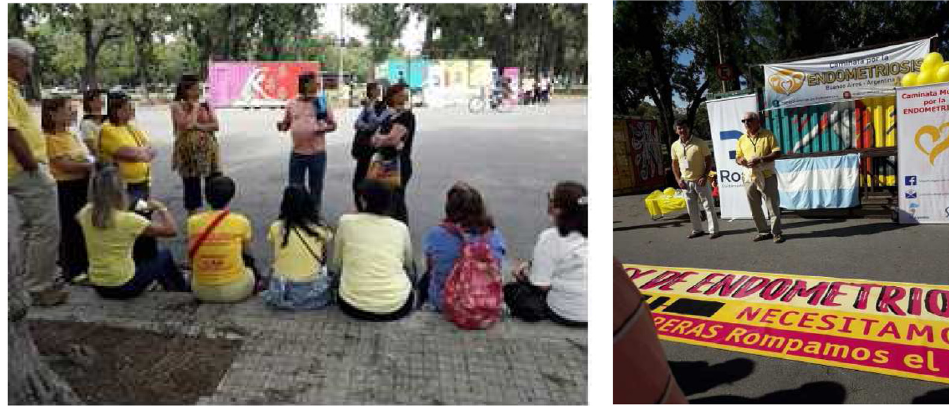
Figure 12. March for Endometriosis (2018). Public awareness talks at a park. Photos by the author.